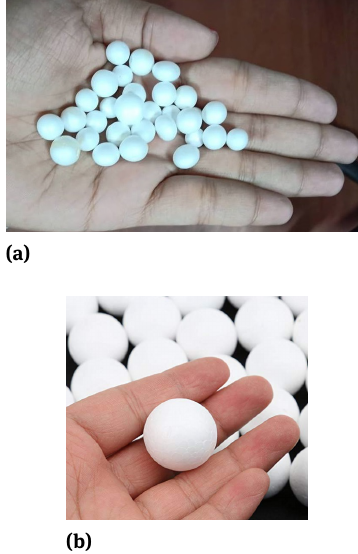
Figure 2: Expanded polystyrene foam balls: (a) 9 mm and (b) 18 mm